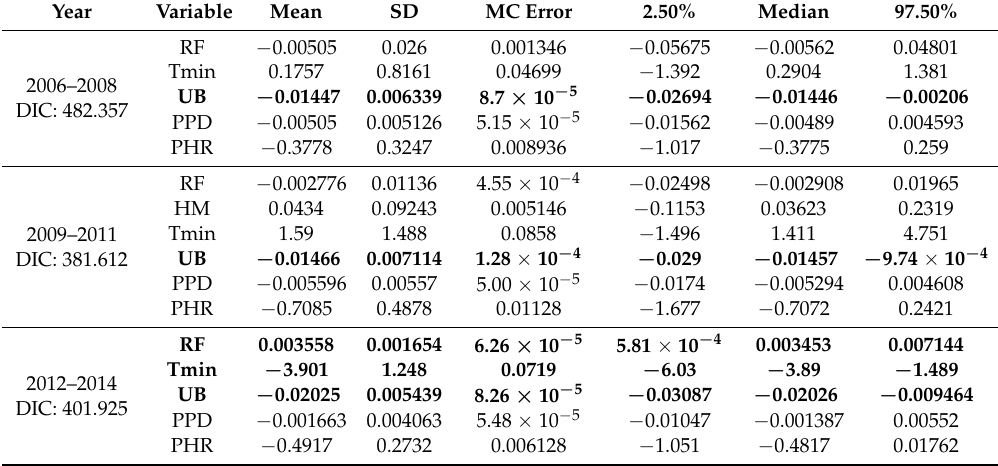
Table 4. Meteorological, socio-economic factors and JE incidences (Model I: three-year aggregated data).